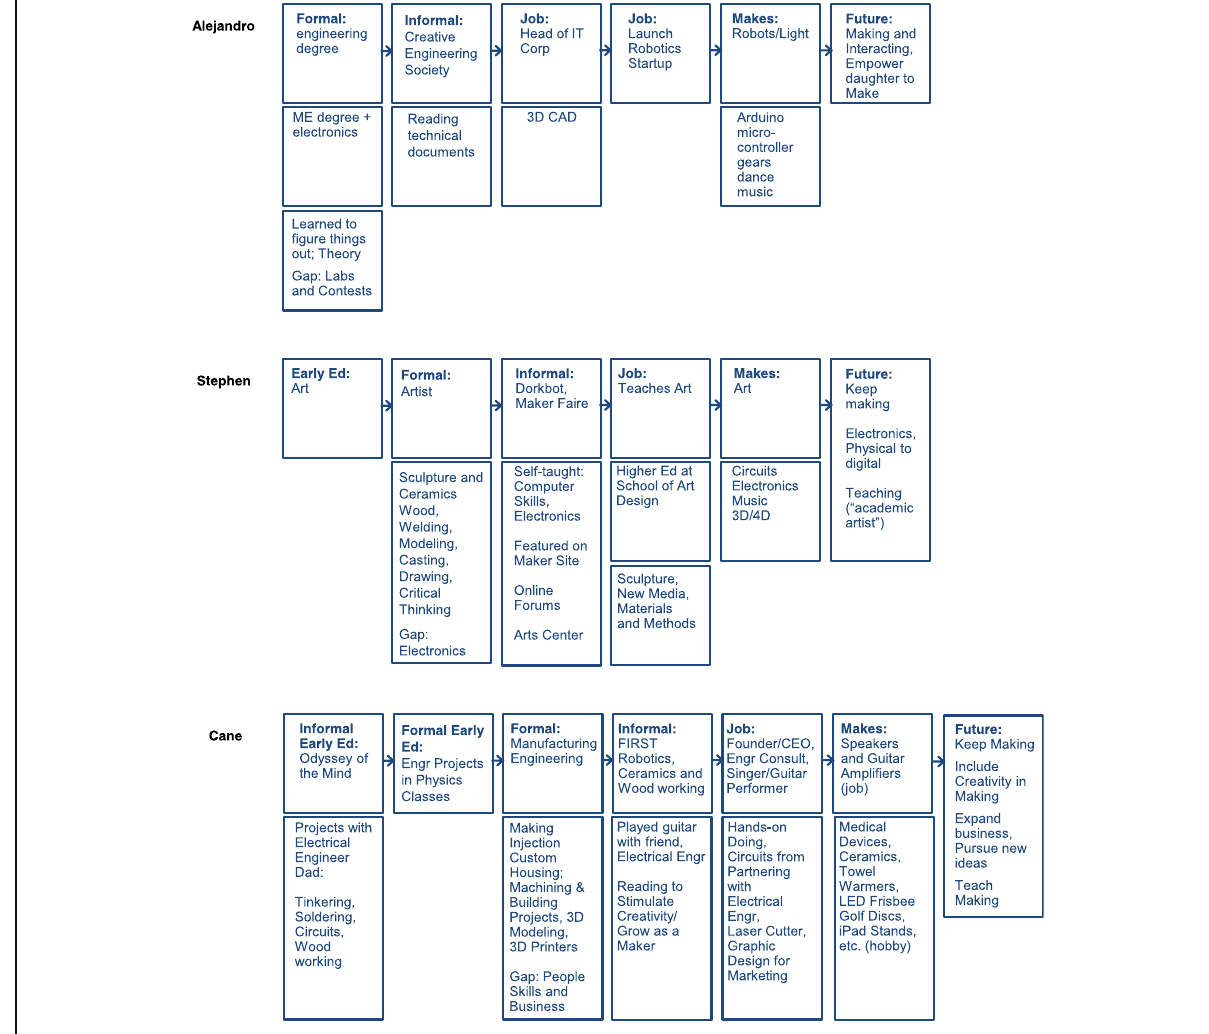
Fig. 4 Parallel pathways for the Makers of musical